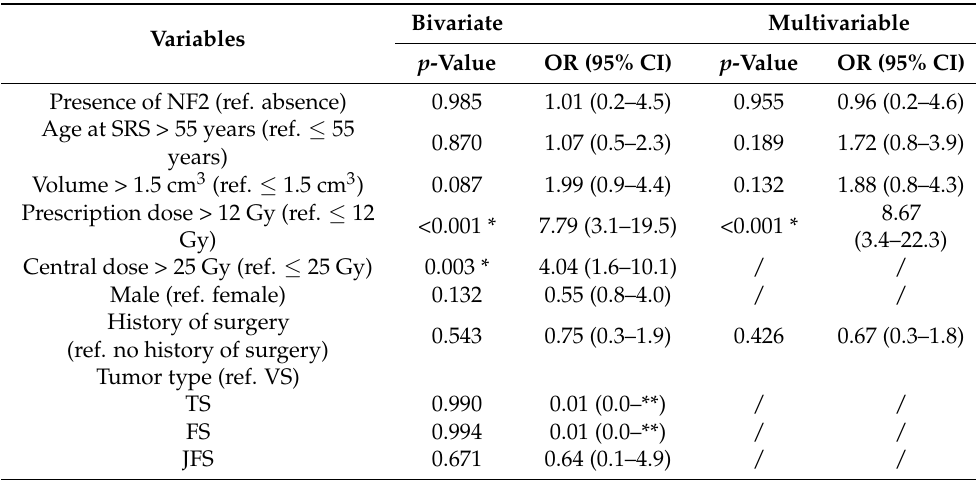
Table 4. Results of bivariate and multivariable analyses of cranial nerve injuries considered radiation- related adverse events before